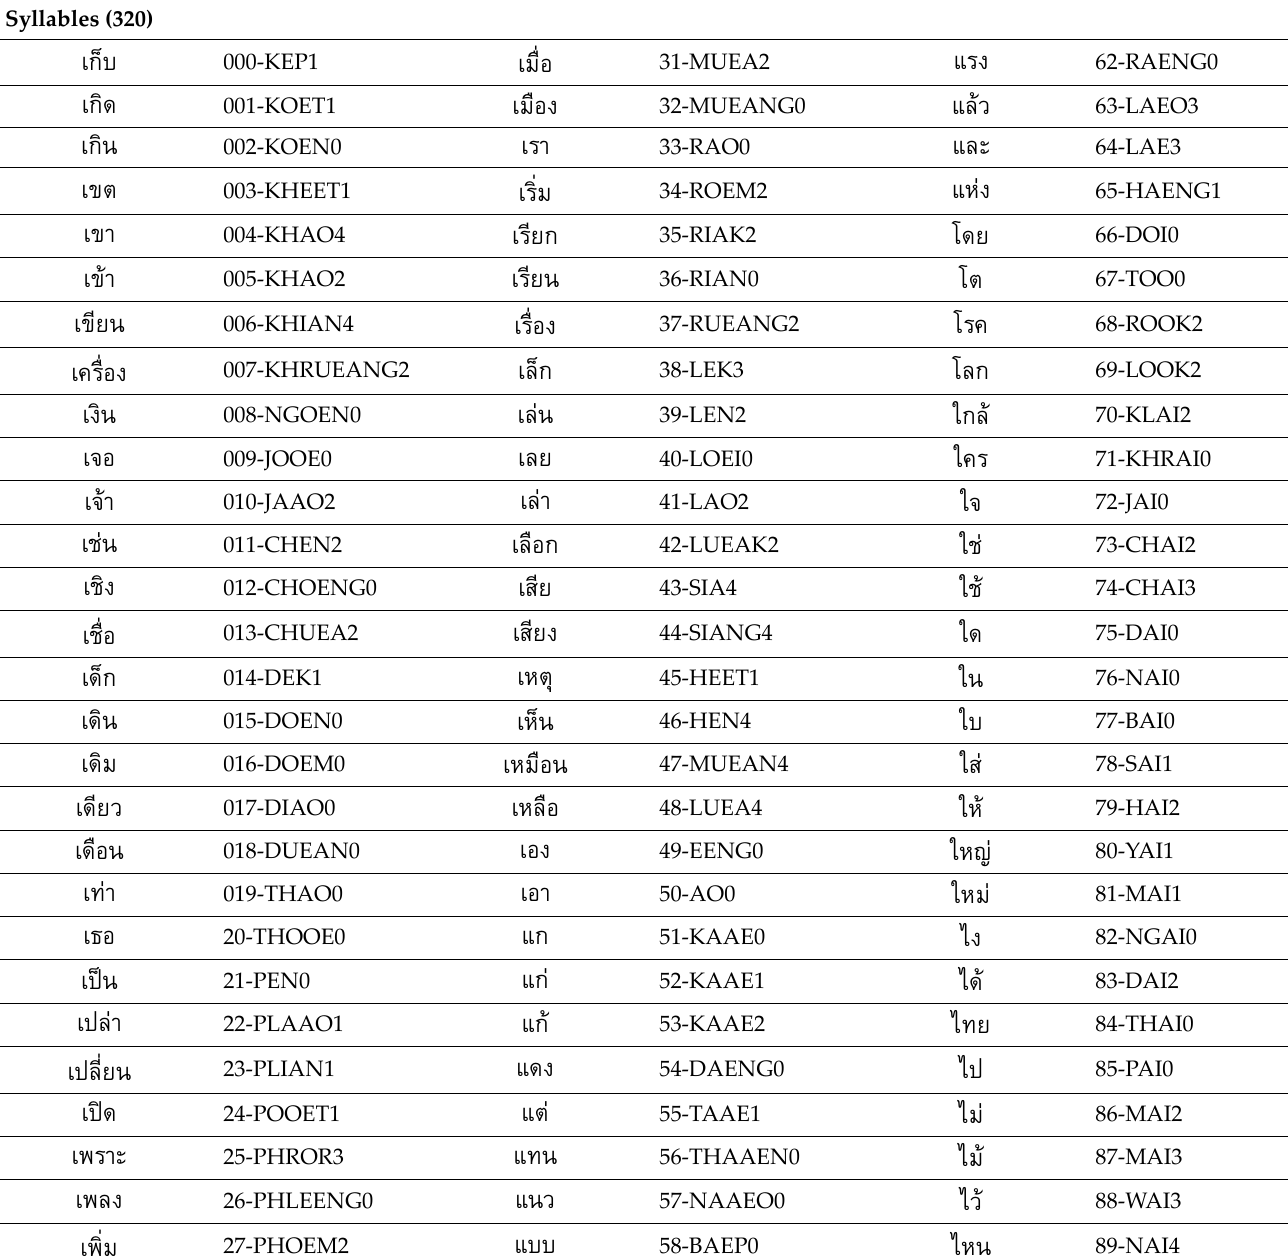
Table A3. Thai Syllable classes considered for the dataset